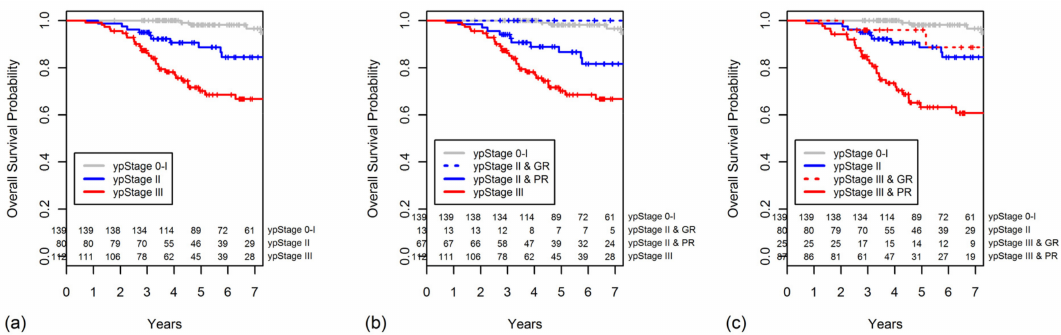
Figure 4. Overall survival curves are shown for categories of ( a ) ypStage, ( b ) ypStage II group was dichotomized as GR or PR, and ( c ) ypStage III group was dichotomized as GR or PR.